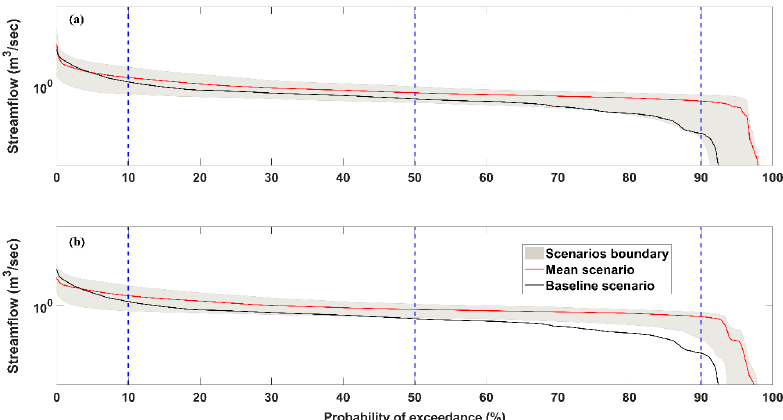
Figure 6. Streamflow duration curve of the Upper Assiniboine River basin at Shellmouth reservoir (HFC station ID: 05MB999) for all climate change scenarios over the period ( a ) 2030s (2011–2040), and ( b ) 2050s (2041–2070).